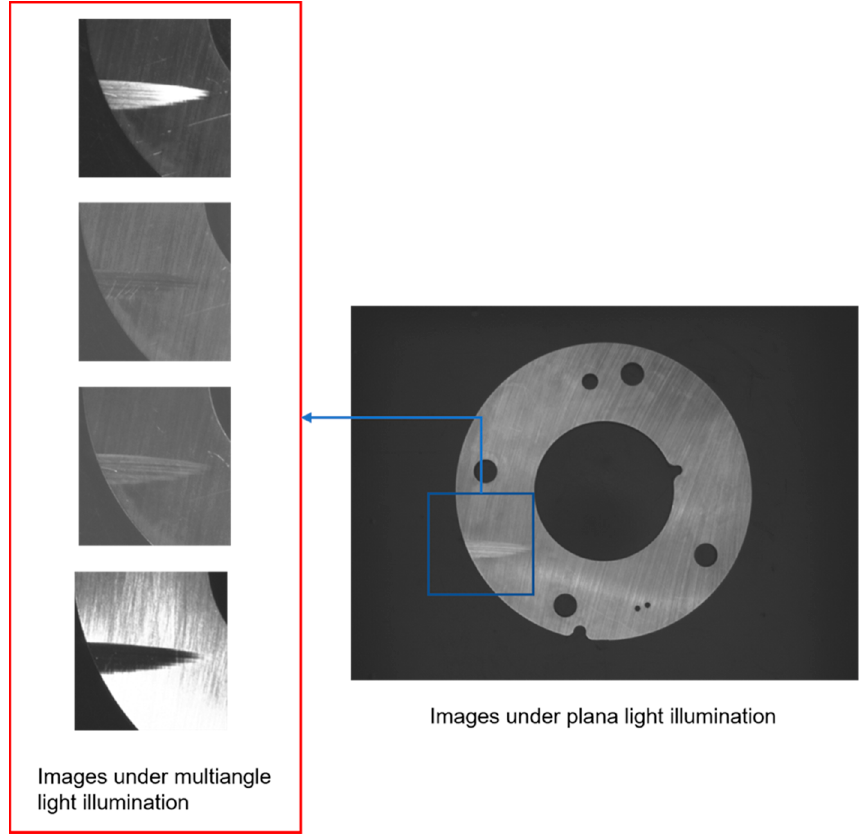
Figure 8. The parts under multiangle illumination. Sensors 2020 , 20 , x FOR PEER REVIEW